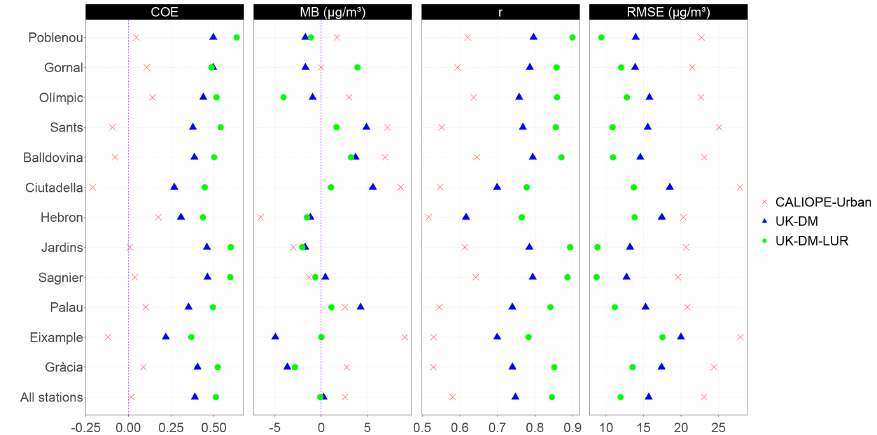
Figure 7. Statistical results for each station after applying UK-DM and UK-DM-LUR to 2019 hourly data in LOOCV. In addition, we show the statistical results for the CALIOPE-Urban estimates at each station. All stations refer to the average over all stations.